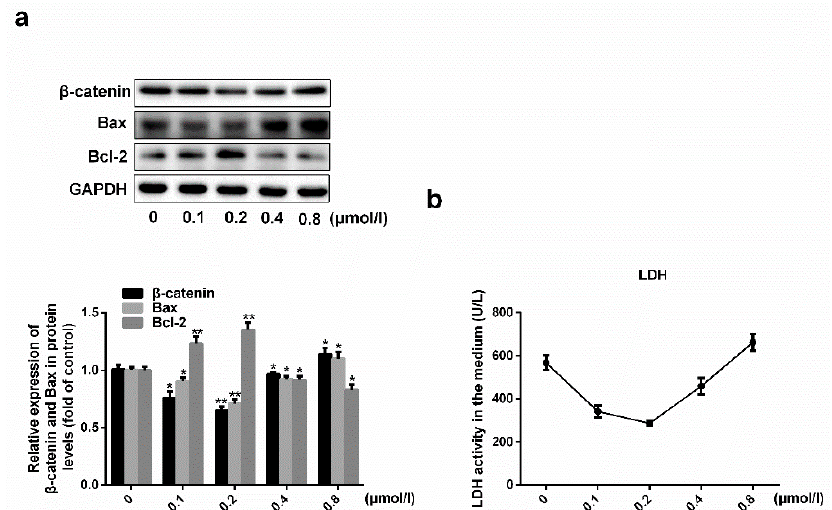
Figure 1. E ff ects of simvastatin on the viability of HUVECs. ( a ) The expressions of Bax, Bcl-2 and β -catenin in protein levels were analyzed by western blot analysis. ( b ) LDH level was measured. * p < 0.05 or ** p < 0.001 versus 0 group, n = 3.